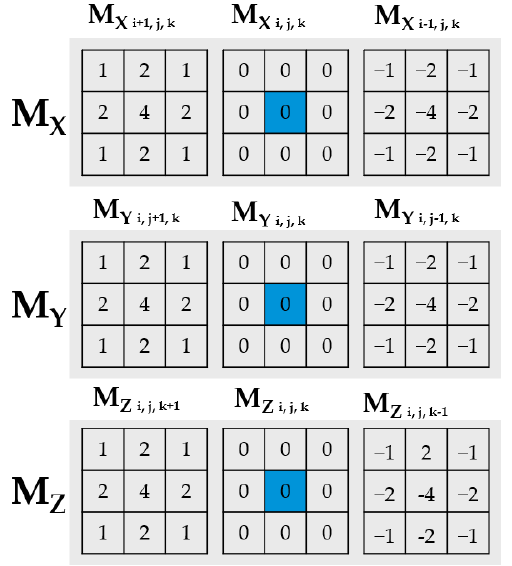
Figure 9. Masks that are used to approximate the gradient across each of the cartesian planes. These masks are akin to the Sobel masks for image processing.